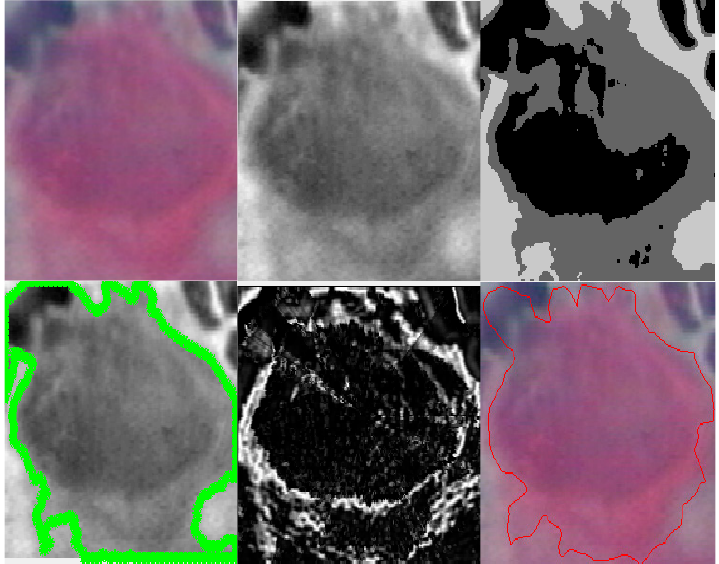
Figure 1. From left to right images represents the carcinoma cell from the Herlev dataset where the input image is given in CIE Lab colour space, and where initially the linear iterative clustering is applied to separate the regions of nucleus and cytoplasm, the optimized graph cut is generating the hyper pixels, and a Bayesian classifier is used to classify the boundaries of nucleus and cytoplasm where the high intensity darker pixels are regions of a nucleus and the red boundary marked is the region of the cytoplasm.